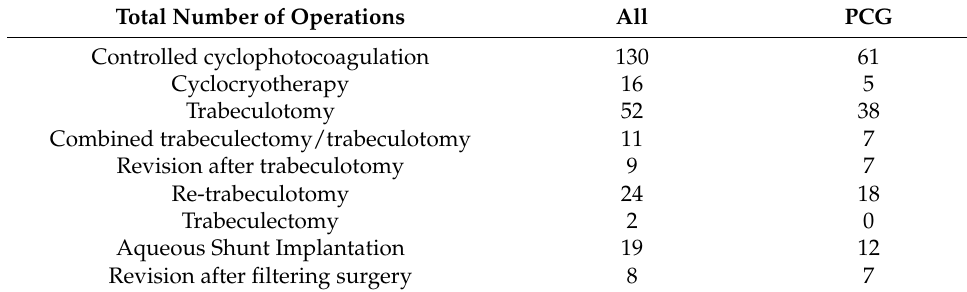
Table 2. Number of